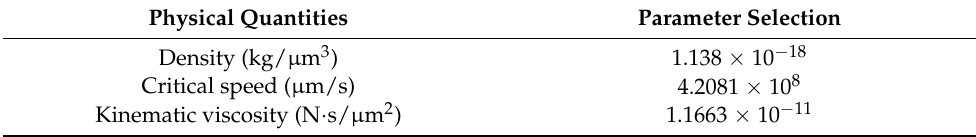
Figure 5. Geometric model of Euler-Lagrange coupling analysis method.